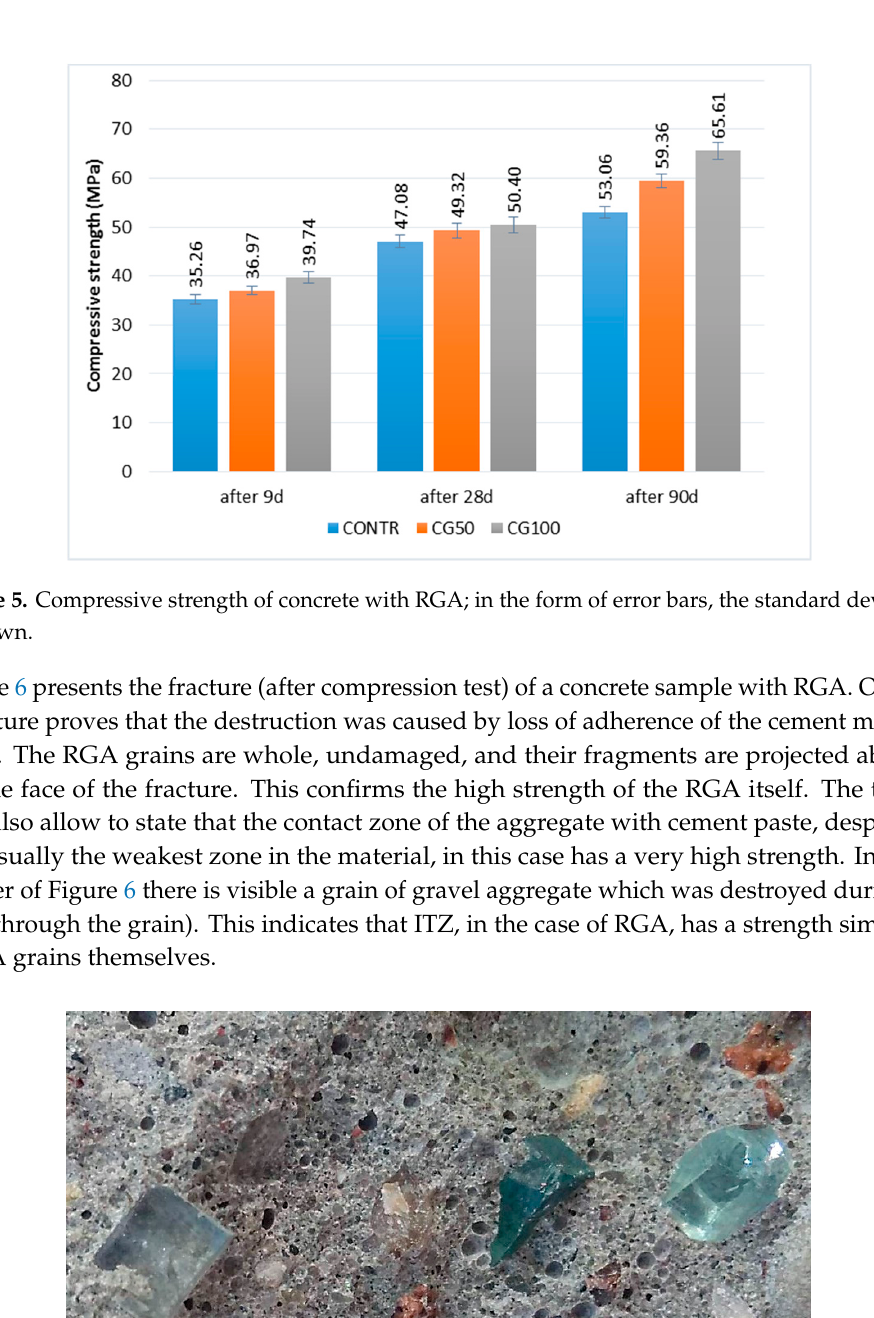
Figure 6. The fracture surface of the concrete sample after the compressive strength test, the undamaged RGA grains are visible.